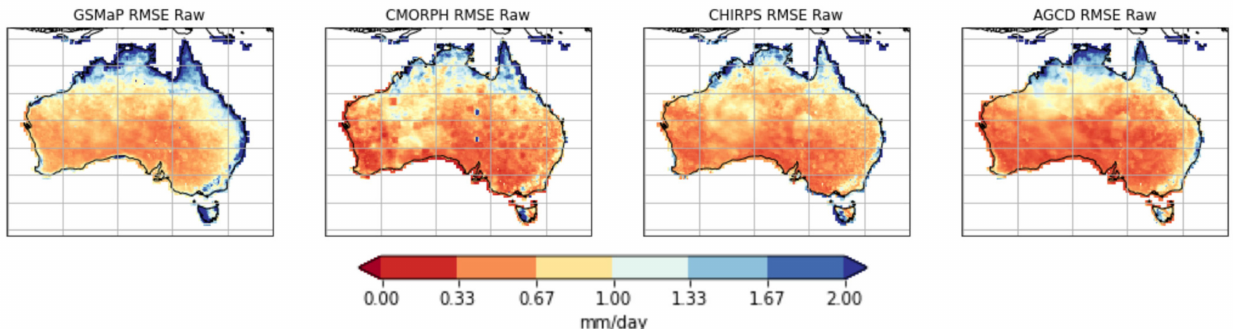
Figure 5. RMSE errors for comparing each dataset to MSWEP across all seasons. Lower values indicate better performance.